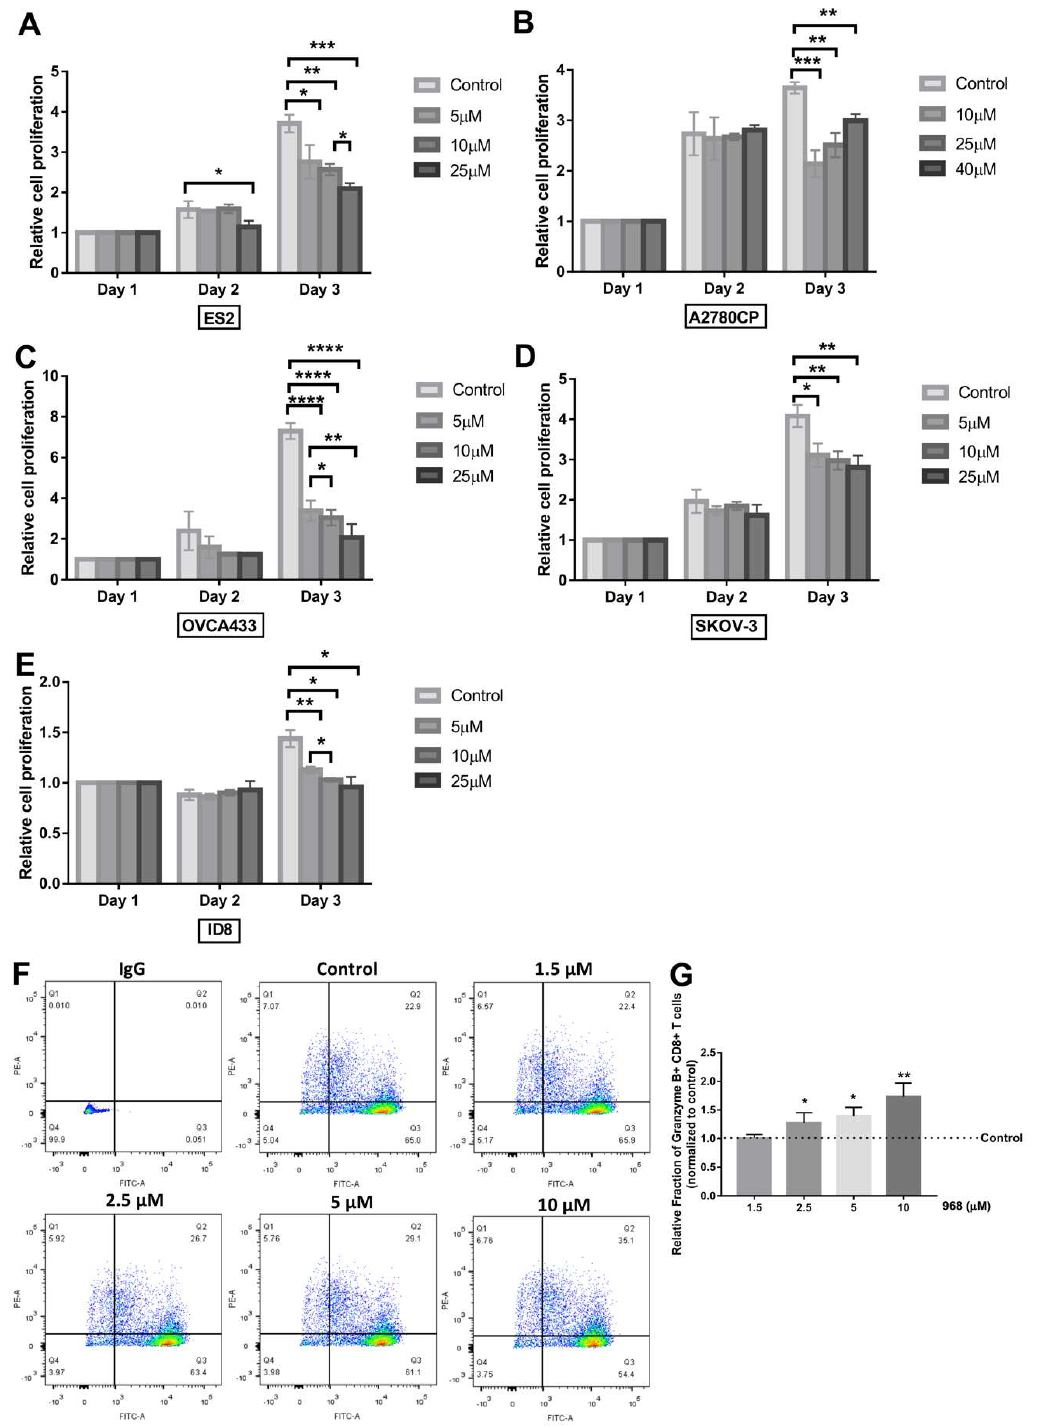
Figure 2. Compound 968 inhibited ovarian cancer cell proliferation and increased granzyme B secretion by CD8 + T cells. The human ovarian cancer cell lines ES2 ( A ), A2780CP ( B ), OVCA433 ( C ), SKOV–3 ( D ), and the mouse–derived ovarian cancer cell line ID8 ( E ) were treated with different concentrations of 968 for different times and XTT was used to examine the growth rate of cancer cells. ( F , G ) CD8 + T cells treated with different concentrations (0, 1.5, 2.5,5 and 10 μM) of 968 for 48 h were stained with antibodies against FITC–labeled CD8A and PE-labeled granzyme B. Representative contour showed granzyme B secretion by CD8 + T cells ( F ) and statistical analysis of these flow cytometry results ( G ). Representative data from three to five experiments are shown (* p < 0.05, ** p < 0.01, *** p < 0.001, **** p < 0.0001).